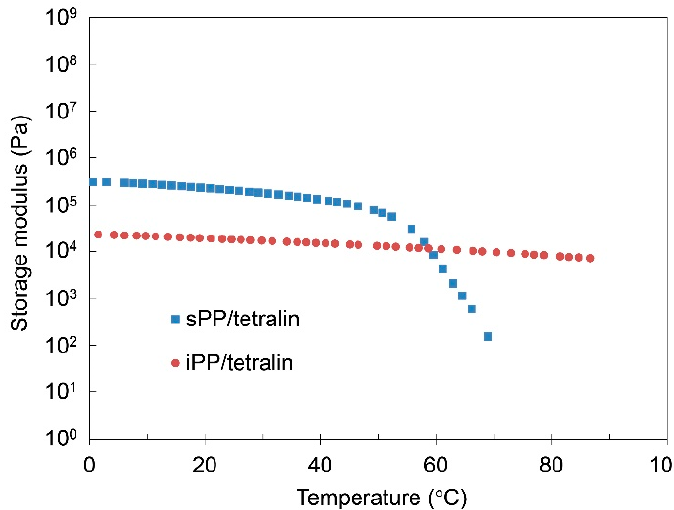
Figure 2. Storage modulus of PP/tetralin10 gels as a function of temperature.